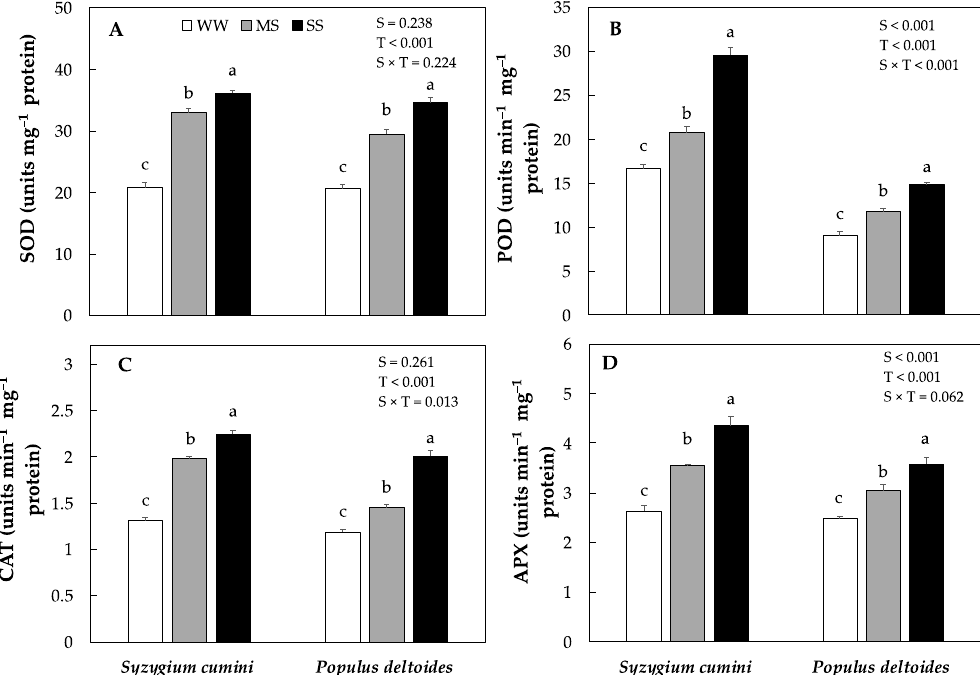
Figure 4. Means of various antioxidants enzyme concentration ( A ) superoxide dismutase, (SOD), ( B ) peroxidase, (POD), ( C ) catalase, and ( D ) ascorbate peroxidase, (APX), under various level of water deficit treatments in Syzygium cumini and Populus deltoides. The traits were tested using a two ‐ way ANOVA for species effect (S ‐ effects), treatment effect (T ‐ effects) and interaction effects (S × T). Values represent the means (±SE) in various treatments. Small letters represent significant difference between treatments within each species tested using the Dunnett’s test. All tests were taken to be significant at p < 0.05.